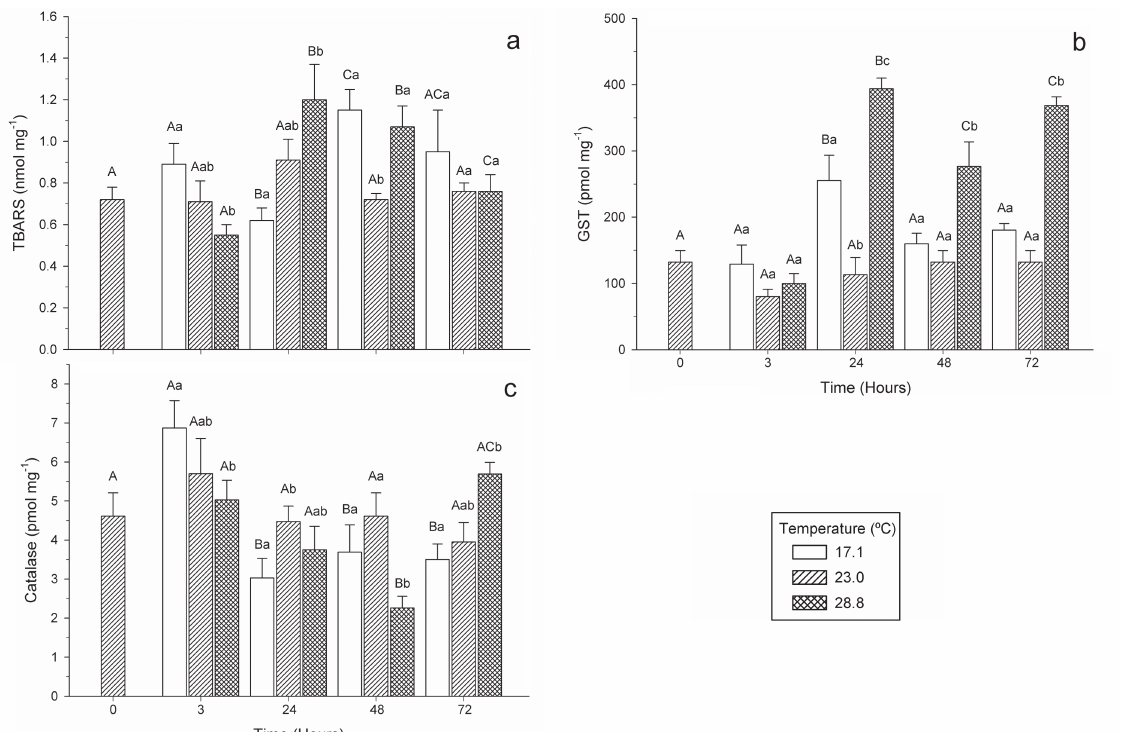
Fig. 1. (TBARS), (GST) and (CAT) activity in the liver of Paralichthys orbignyanus juveniles exposed to different temperatures (17.1, 23.0 and 28.8ºC) as a function of time exposition (72 h). Values are expressed as means ± SEM, N=5. a Lower case letters indicate significantly different at the different temperatures and same time ( P < 0.05), determined by two-way ANOVA and by Dunnet test. A Capital letters indicate significantly different at the same temperatures and different times ( P < 0.05), determined by two-way ANOVA and by Dunnet